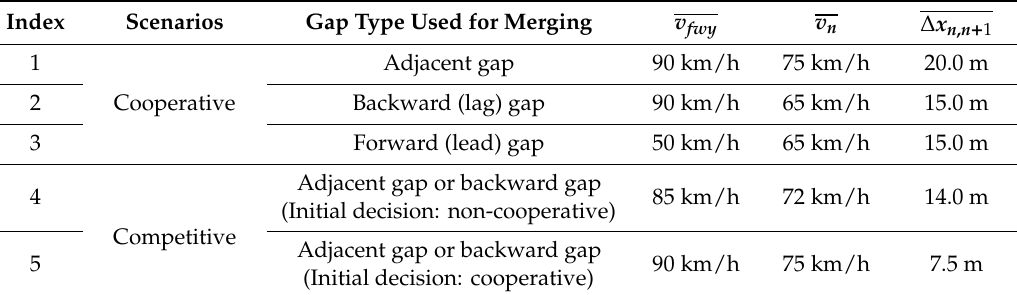
Table 5. Initial Conditions of Merging Scenarios for Case